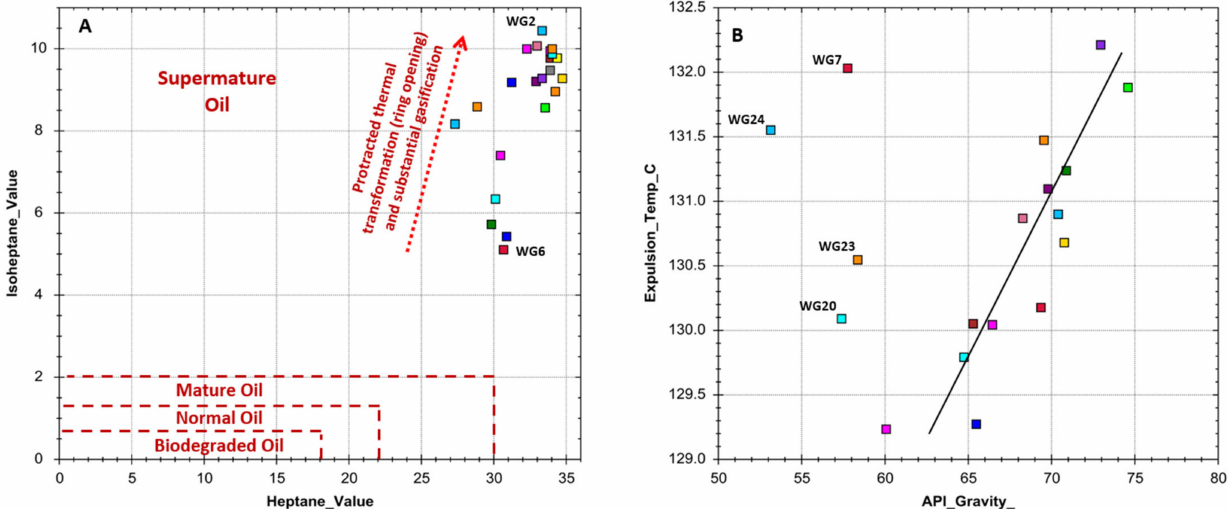
Figure 15. ( A ) Heptane ratio versus isoheptane ratio for Marcellus Formation condensates produced in the wet gas region. The heptane and isoheptane ratios reflect the relative abundance of C 7 structural isomers in the fluid [52]. ( B ) API gravity versus C 7 generation/expulsion temperature for Marcellus Formation condensates produced in the wet gas region. The API values of most condensates correlate with C 7 expulsion temperatures. The well ID (Table 6) of the four samples falling off of the correlation is shown next to the data